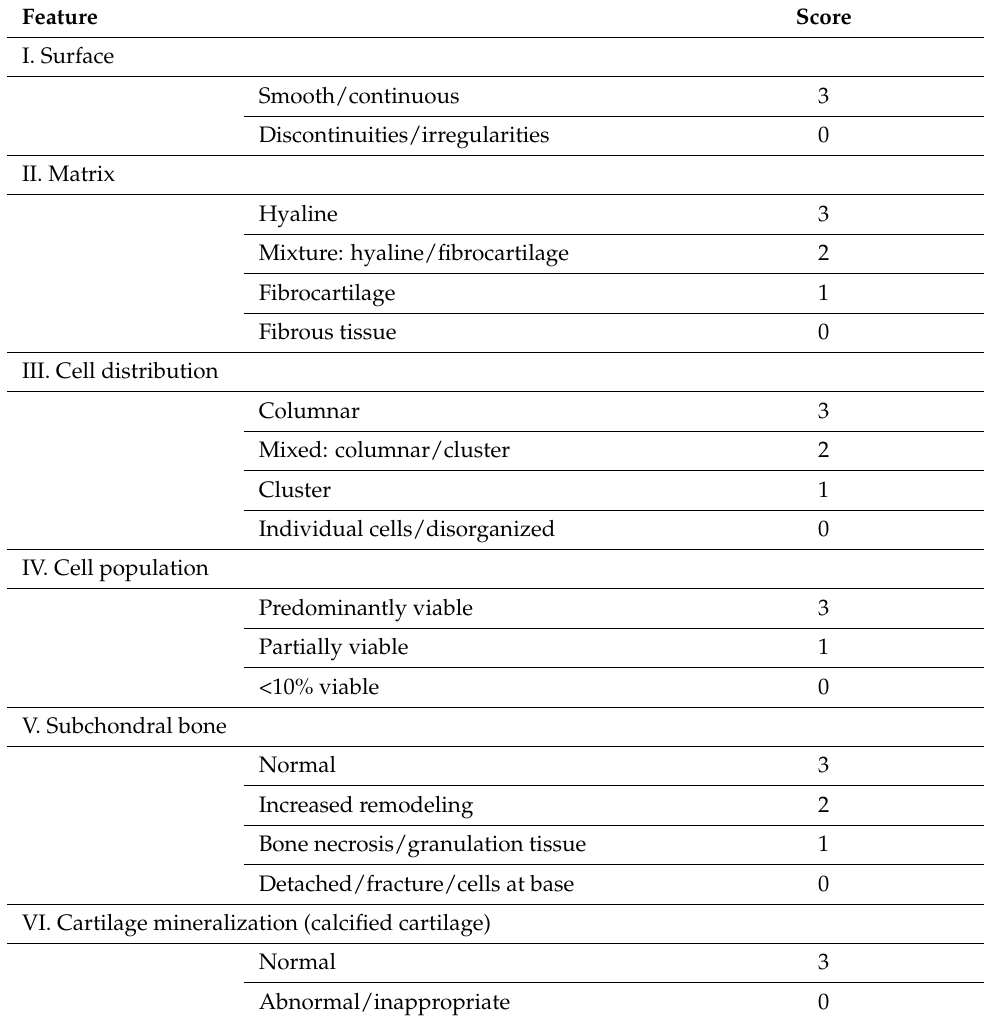
Table 3. International Cartilage Repair Society Histological Assessment